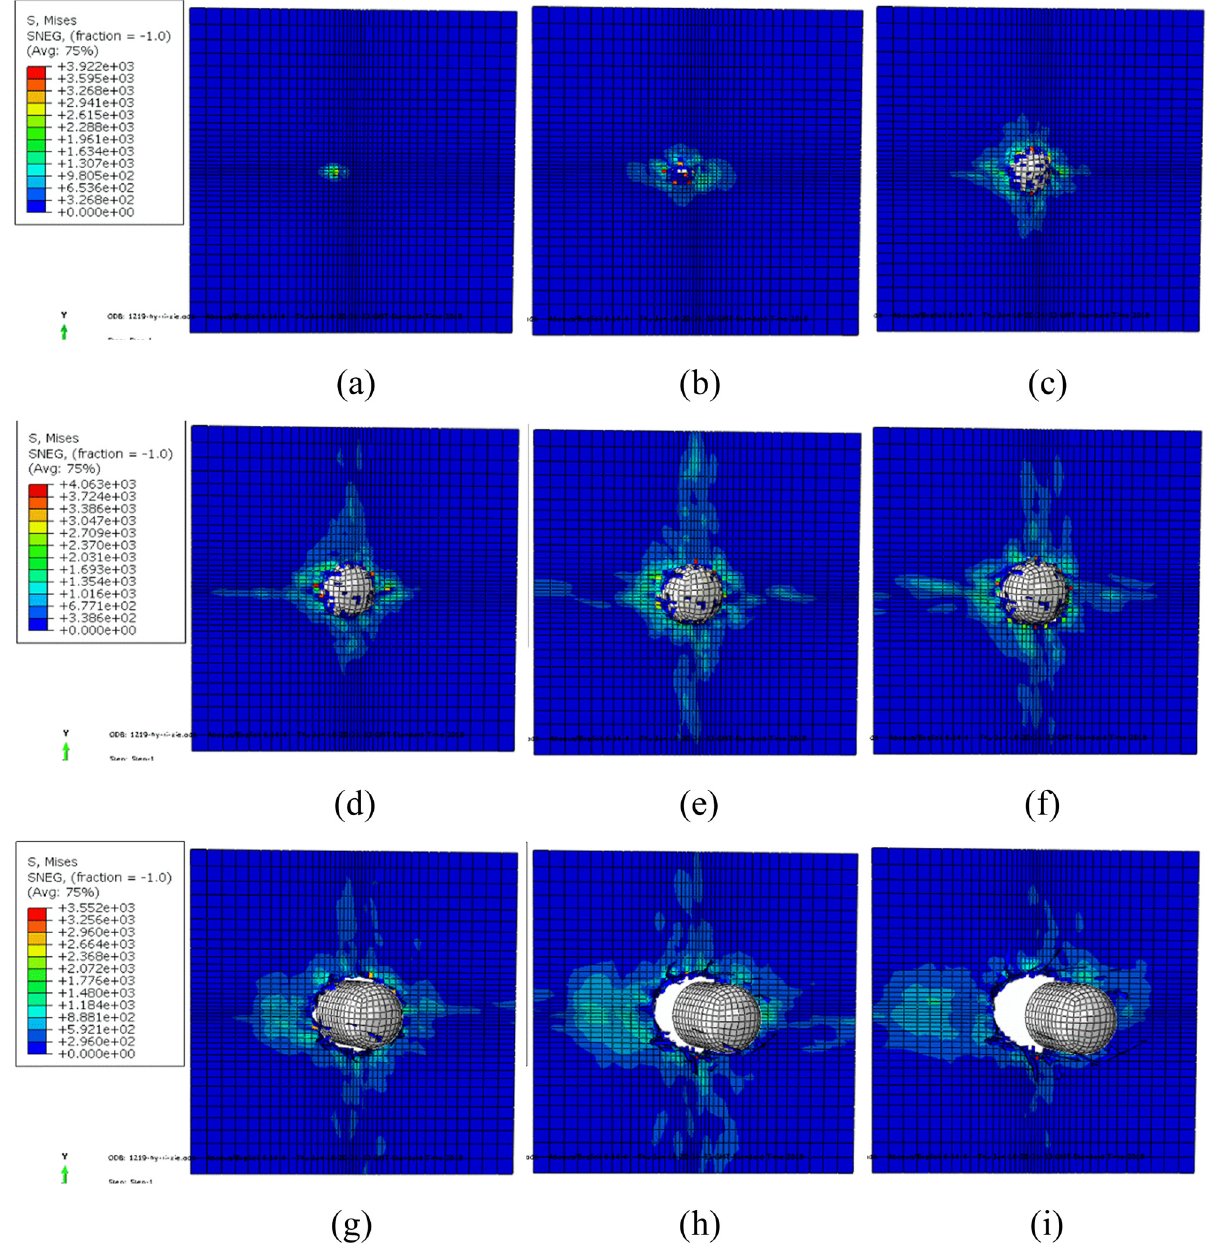
Figure 5: Simulated stress contours of 800 m/s oblique impact: ( a ) 5 μ s, ( b ) 10 μ s, ( c ) 15 μ s, ( d ) 20 μ s, ( e ) 25 μ s, ( f ) 30 μ s, ( g ) 35 μ s, ( h ) 40 μ s, and ( i ) 45 μ